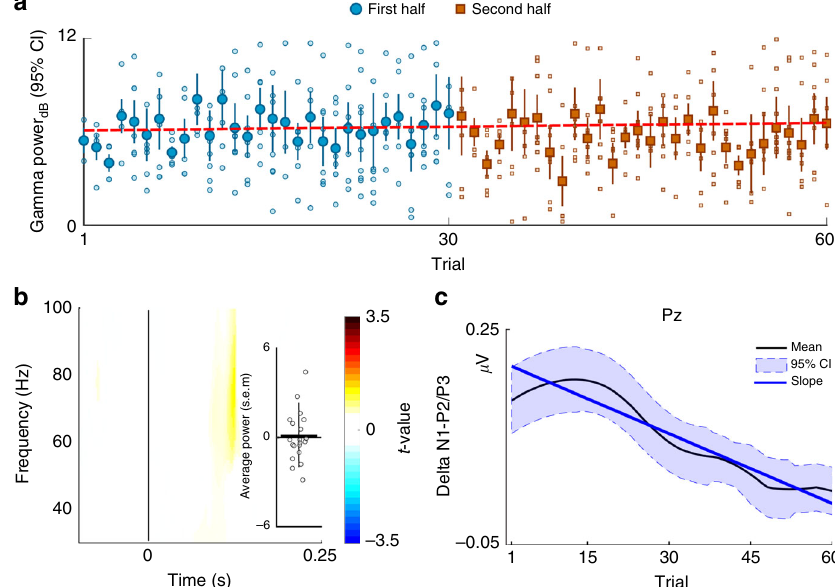
Fig. 4 Lack of habituation of the EBG measure ( n = 21). a Linear mixed model demonstrate that an odor habitation paradigm produce no signi fi cant change in power of the olfactory evoked synchronization across trials tested by a one sample t -test, slope = 0.008, t (437) = 1.58 p > 0.11 CI = [ − 0.002, 0.02]). Blue circles in fi gure represent the mean of each trial for fi rst half and rust colored cubes the second half of the total number of trials. Error bar show 95% con fi dence interval. Un fi lled circles and cubes represent individual values and dashed line indicate the slope as a function of trials. b T-statistics with 1000 Monte Carlo permutations demonstrating no signi fi cant change in power ( p > .05). Positive values indicate larger signal for early trials. Error bar show 95% con fi dence interval and circles indicate individual values. c Pz potentials were band-pass fi ltered and the local minima and maxima within the time intervals of interest were detected as the peak of N1 and P2/3, respectively. Black curve shows the mean N1-P2/3 peak-to-peak responses in the olfactory event-related potentials (ERPs) over the Pz electrode as a function of trials and shaded blue area shows 95 % con fi dence interval. The mean curve is smoothed for presentation purposes. Blue line represent the slope revealed by the linear model and indicate a decrease in amplitude difference between N1-P2/P3 ERP components at electrode Pz across trials.